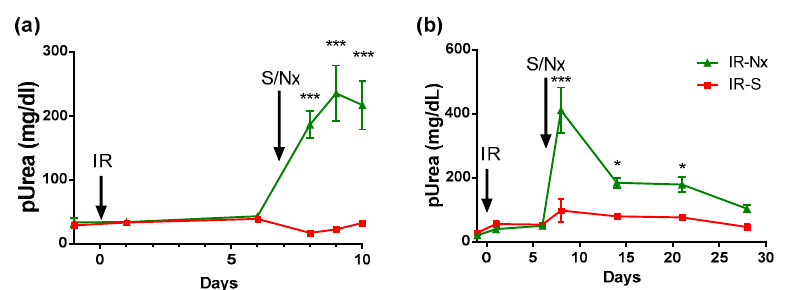
Figure 1. Effects of nephrectomy (Nx) on plasma urea concentrations in mice with left renal ischemia-reperfusion injury (IRI). ( a ) Blood samples were taken on days -1, 1, 6, 8, 9 and 10 in the 10-day study. ( b ) Blood samples were taken on days -1, 1, 6, 8, 14, 21 and 28 in the 28-day study. Data are expressed as mean ± SEM; two-way ANOVA with Tukey’s post hoc test; *: p < 0.05 and ***: p < 0.001; IR-S (sham) vs. IR-Nx.